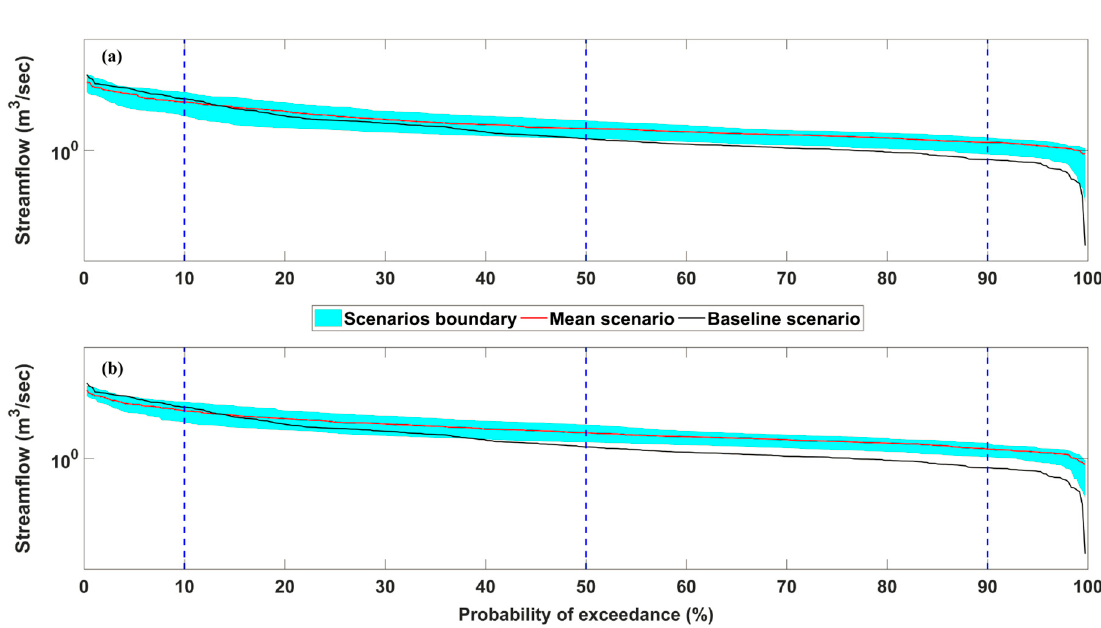
Figure 9. Flow duration curves for the ( a ) 2030s and ( b ) 2050s indicating 10%, 50%, and 90% quantiles for observed (1980–2010), mean, and spread (minimum and maximum) of land use and climate change scenarios at the catchment outlet (WSC ID: 05MD004). Table 5. Quantitative comparison (in %) of baseline scenario to mean, maximum, and